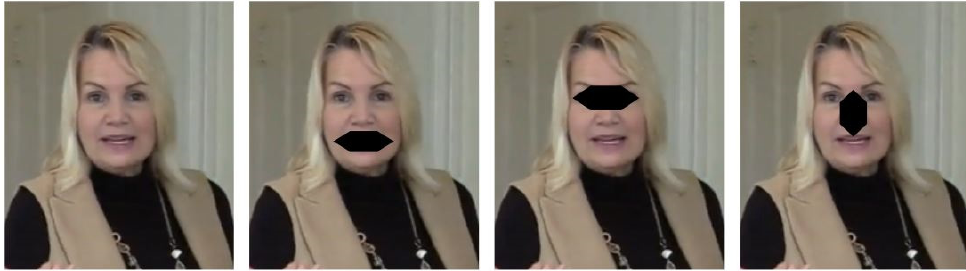
Figure 2. ( a ) The original face without any augmentation. ( b–d ) Three types of augmentation: cut- out of mouth, eyes and